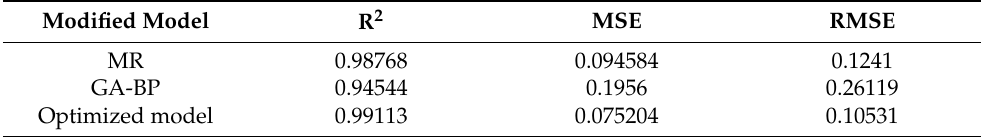
Table 5. Prediction indices for verification set algorithms.